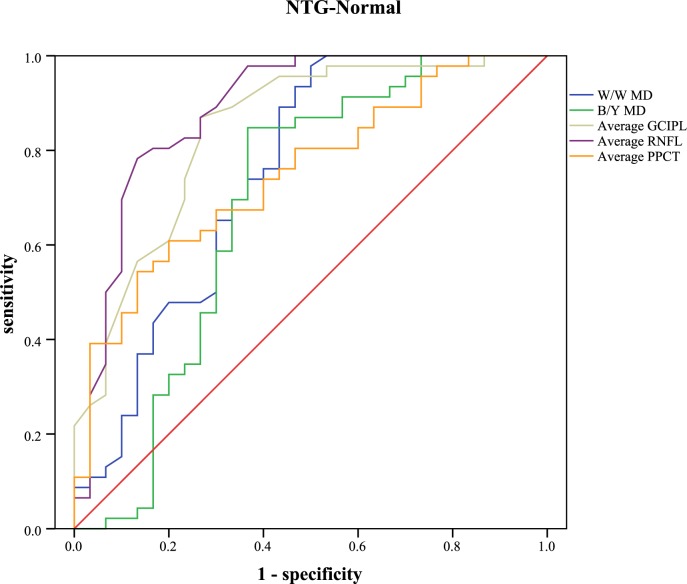
ROC curves for visual field indices and OCT parameters to discriminate NTG from normal eyes.